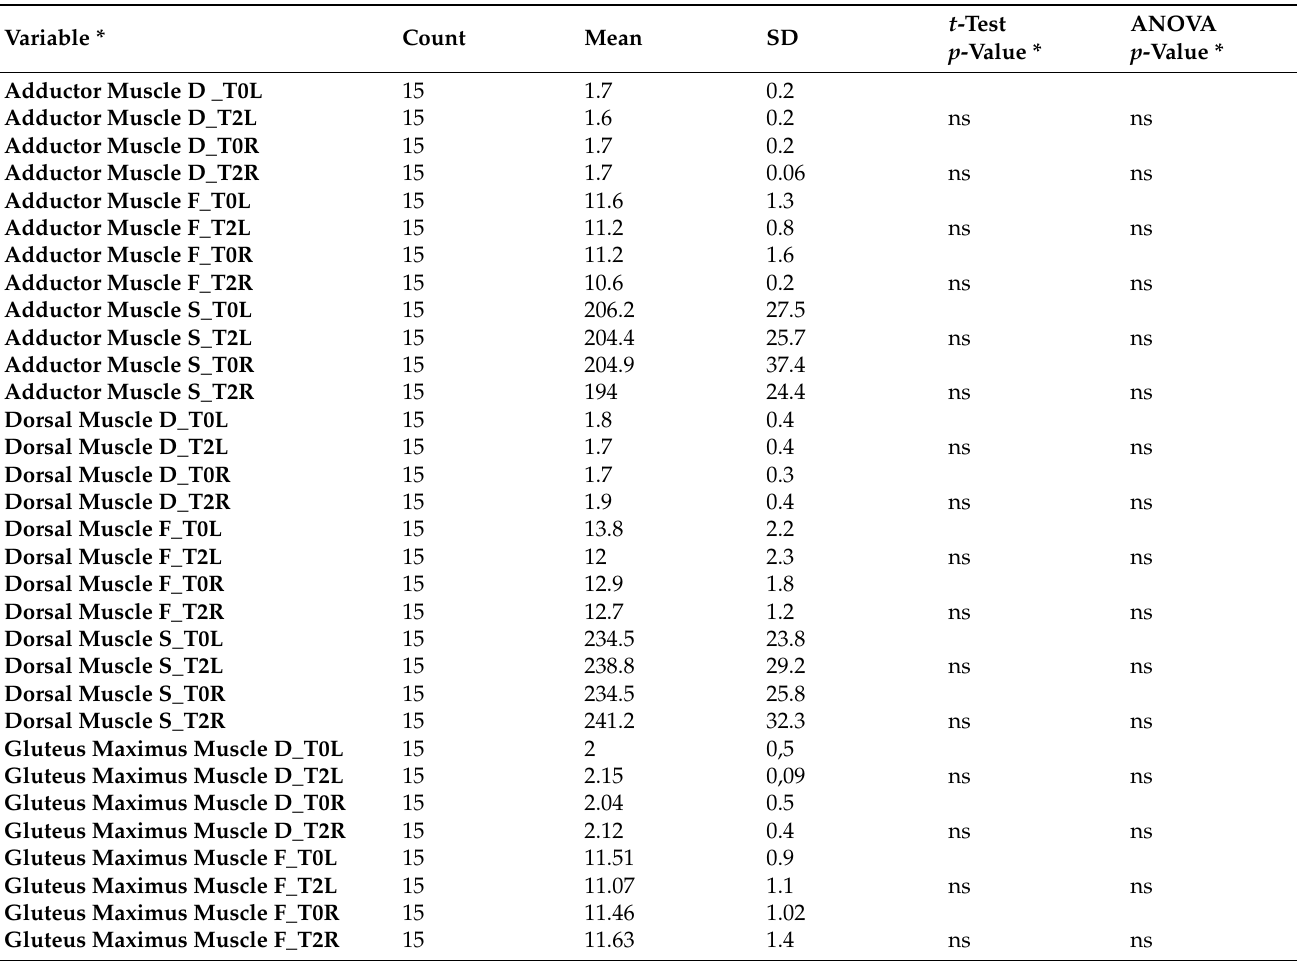
Table 1. Outcome measures statistical analysis in MyotonPRO